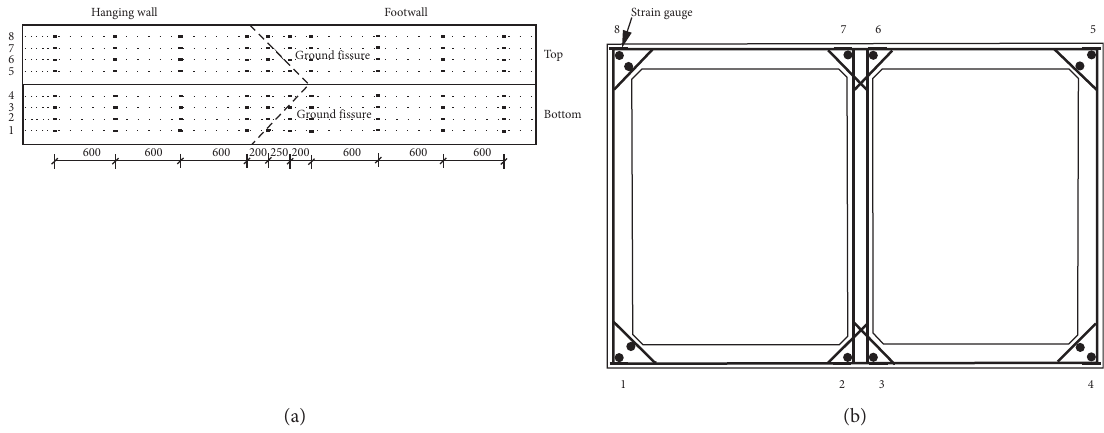
Figure 7: Structural longitudinal reinforcement strain gauge layout (cm). (a) Position of longitudinal rebar strain gauges (cm). (b) Longitudinal rebar section strain gauges layout